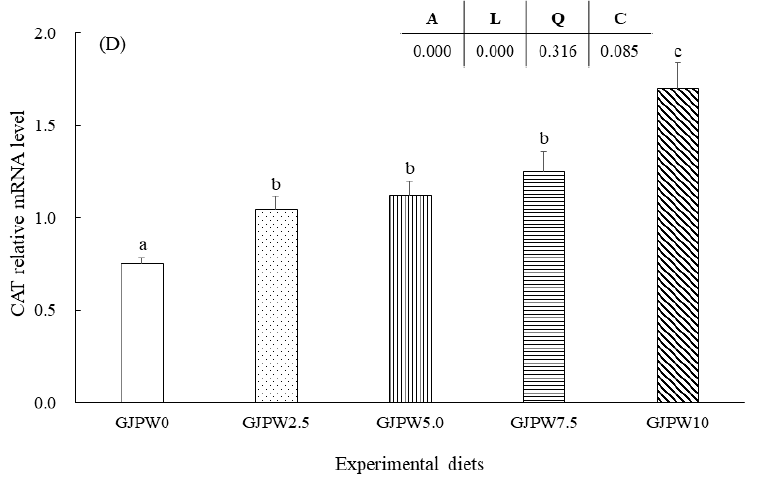
Figure 1. Relative expression [insulin-like growth factor (IGF-1) (A), superoxide dismutase (SOD) (B), glutathione S-transferase (GST) (C), and catalase (CAT) (D)] in liver samples of juvenile black rockfish fed with different levels of garlic juice processing waste (GJPW) for 8 weeks. All data are shown as mean ± SE of three replicates. Bars with different letters show statistically significant dif- ferences ( p < 0.05).